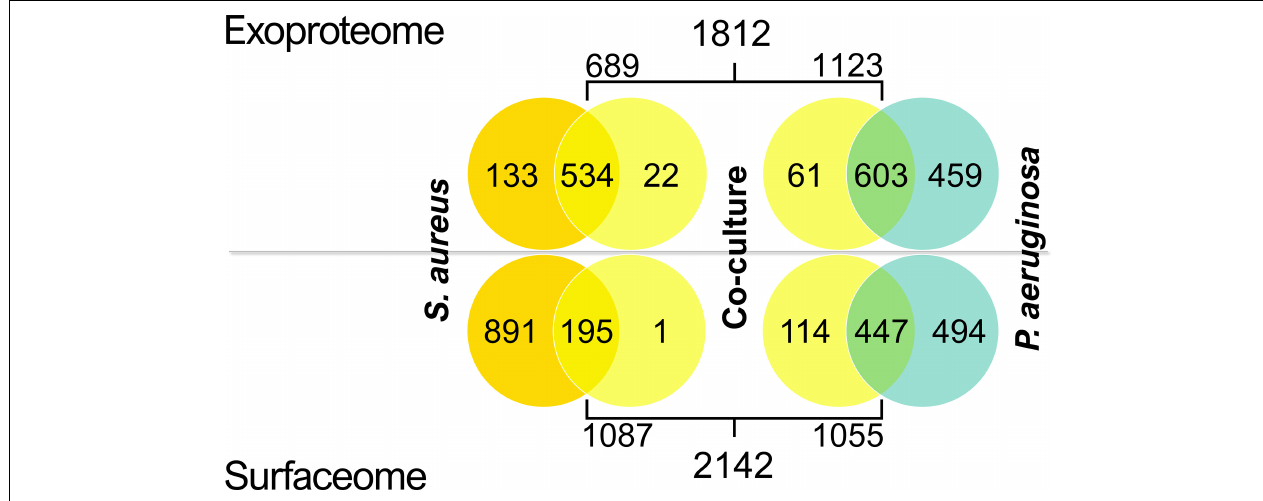
FIGURE 4 | Venn diagrams displaying the number of valid identifications (present in at least two out of three replicate samples) in the exoproteomes and surfaceomes in Staphylococcus aureus and Pseudomonas aeruginosa co-culture